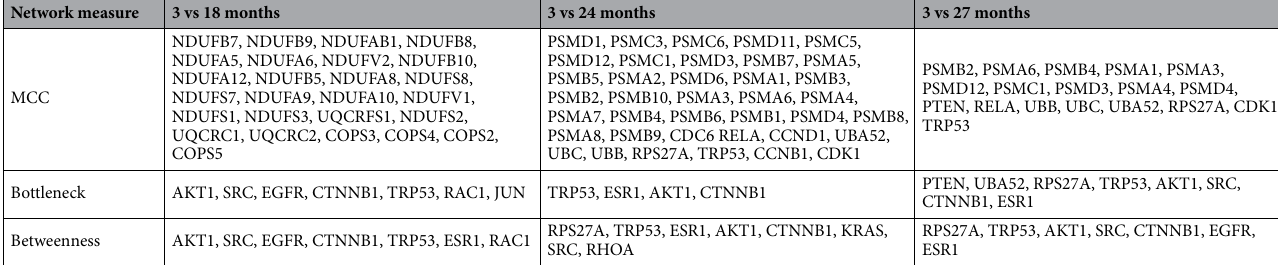
Table 3. Hub nodes of liver ageing network based on local and global network